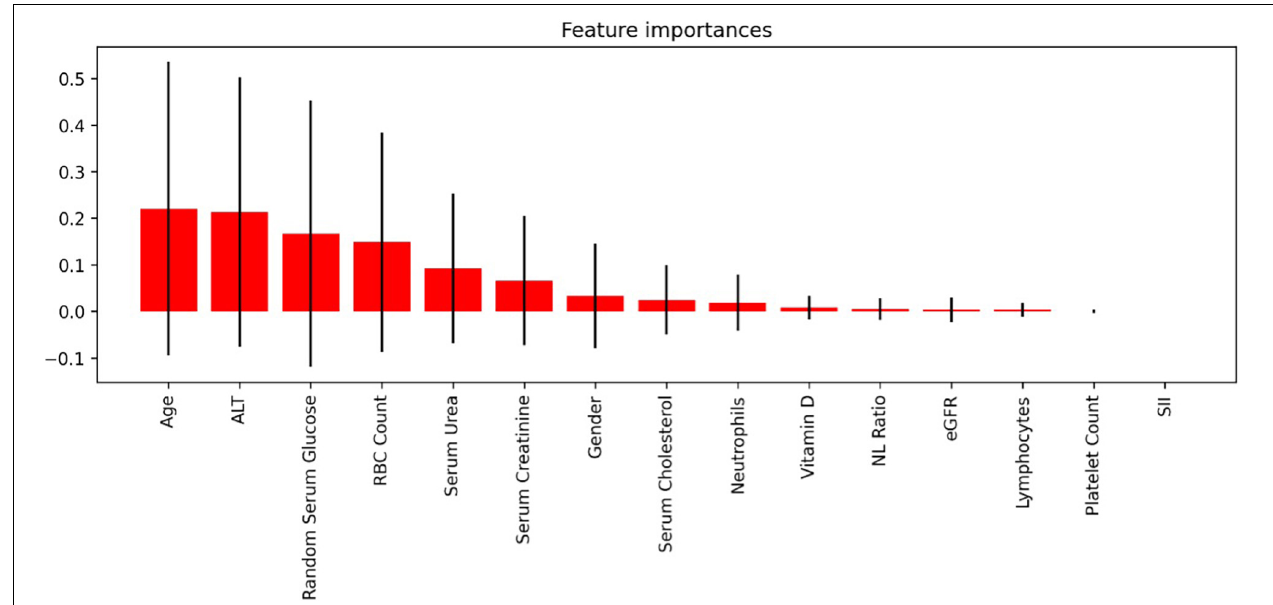
FIGURE 2 | Feature importance of each parameter assessed for the predictive model.